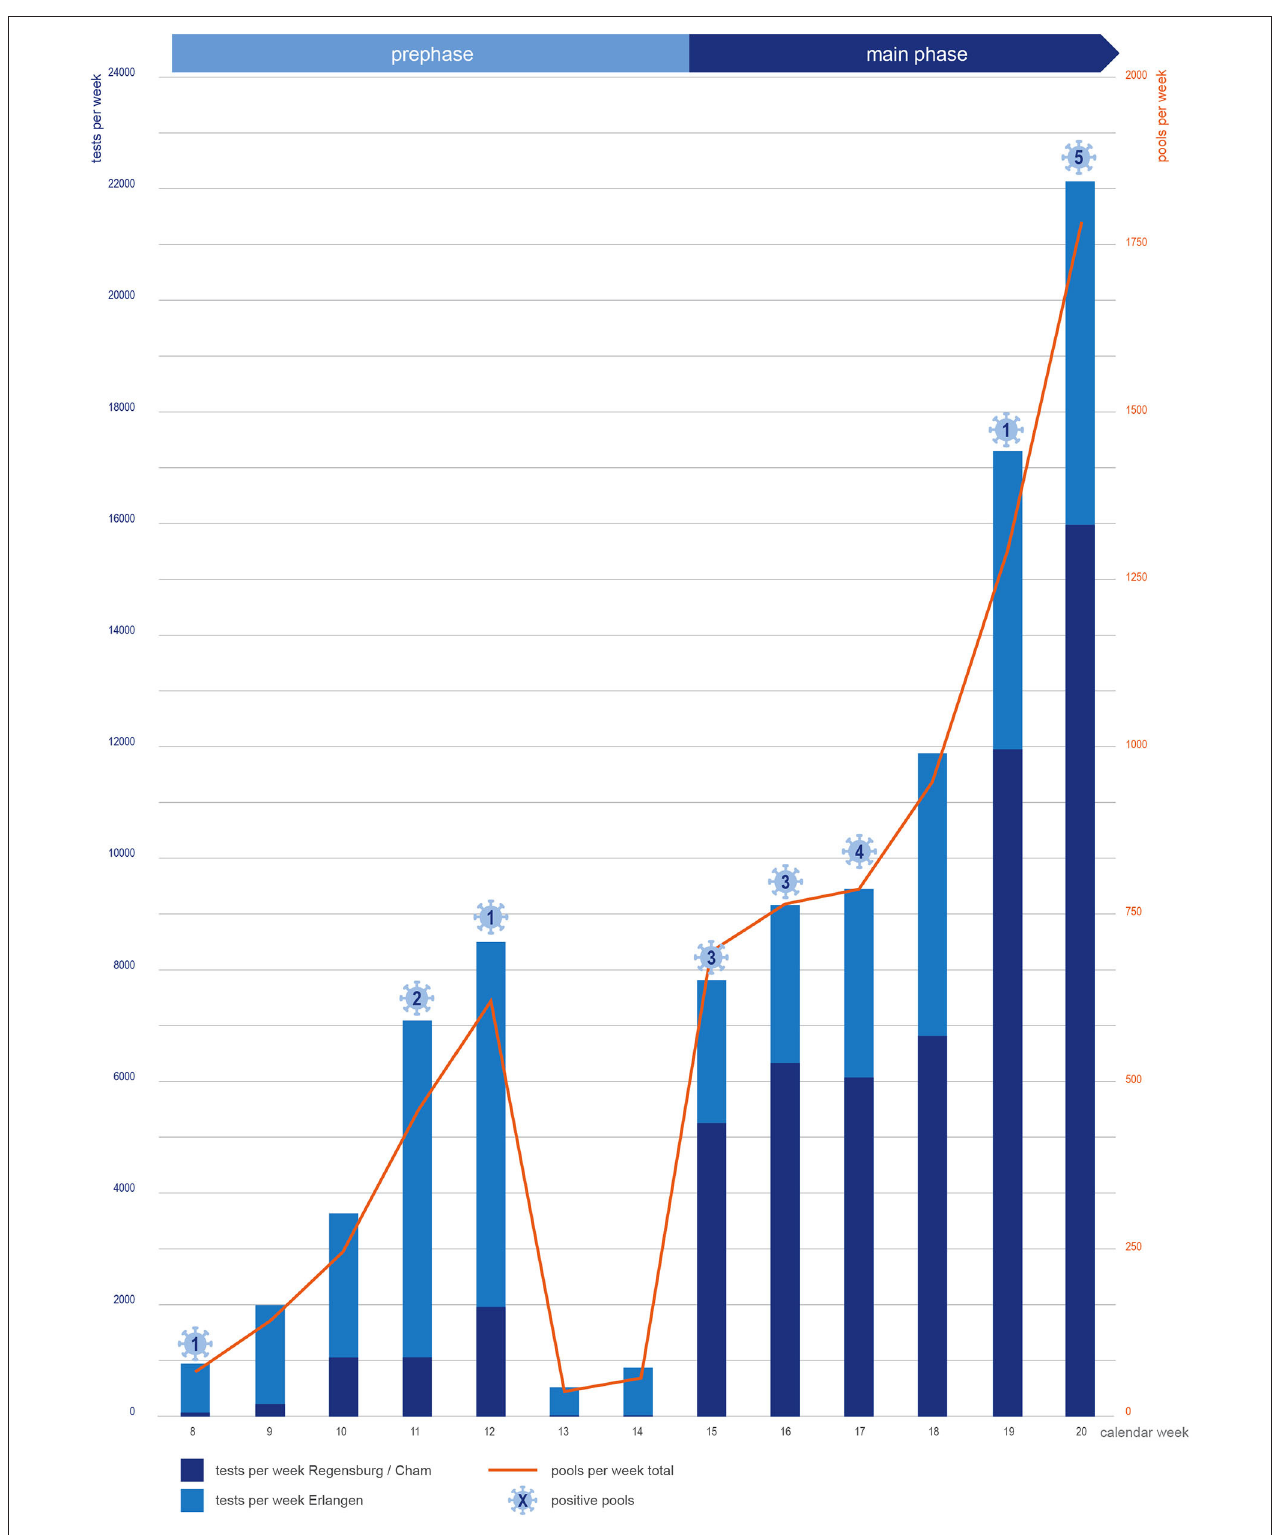
FIGURE 4 | Development of test and pool numbers in the pilot and main phase of the WICOVIR project and positive results of testings per week.